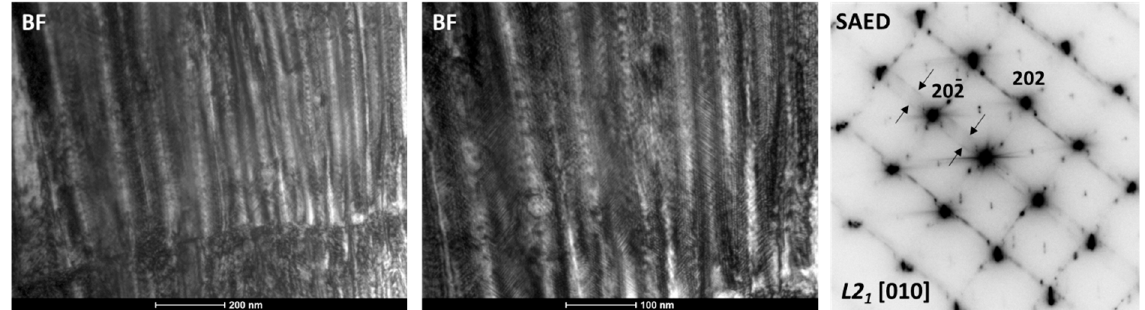
Figure 8. Bright field (BF) and the corresponding selected area electron diffraction (SAED) of as laser melted Ni-Mn-Ga-Fe powder taken from an area dominated with the L2 1 austenite phase.